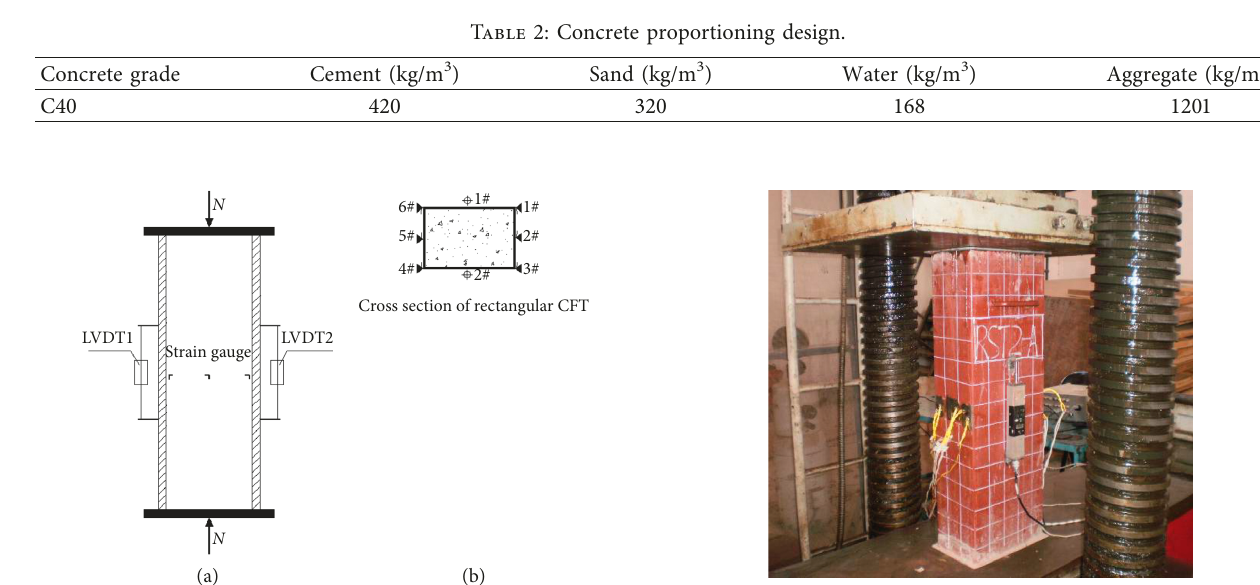
Figure 3: Experimental setup.